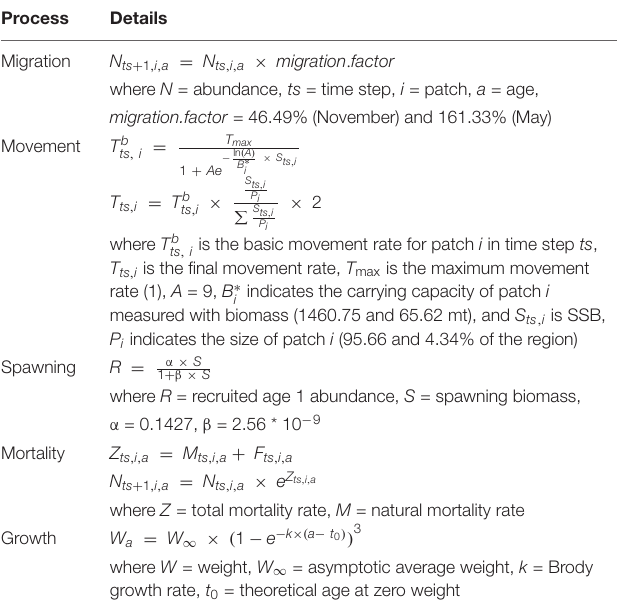
TABLE 1 | Population dynamics simulated with the projection